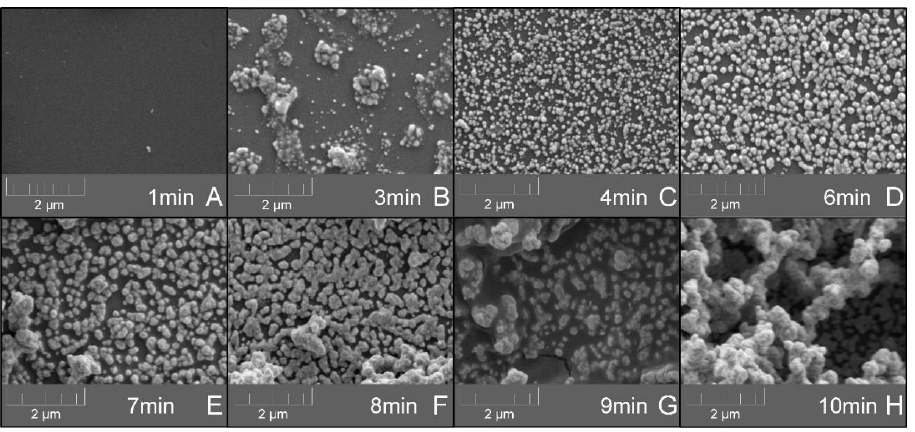
Figure 7. Scanning electron microscopy (SEM) characterization of the effect of the deposition time on the formation of silver nano-islands. The surface morphology was characterized by an SEM model MIRA3 from TESCAN (Brno-Kohoutovice, Czech Republic), at a 5 kV accelerating voltage. Before imaging, a thin layer of palladium gold was deposited onto the samples in order to render them electrically conductive and to avoid potential surface charging by the electron beam. The influence of the silver-deposition reaction duration of ( A ) 1 min; ( B ) 3 min; ( C ) 4 min; ( D ) 6 min; ( E ) 7 min; ( F ) 8 min; ( G ) 9 min; and ( H ) 10 min, was investigated. A clear correlation is visible between the deposition time and the size and amount of the silver nano-islands. Longer deposition time resulted in significantly-larger silver nano-islands (8 > 7 > 5 > 4